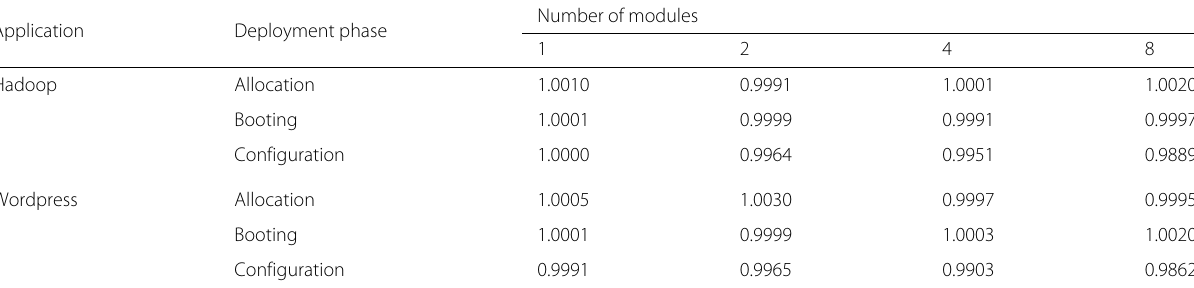
Table 2 Relative Deployment Time for Openstack Heat vs AURA